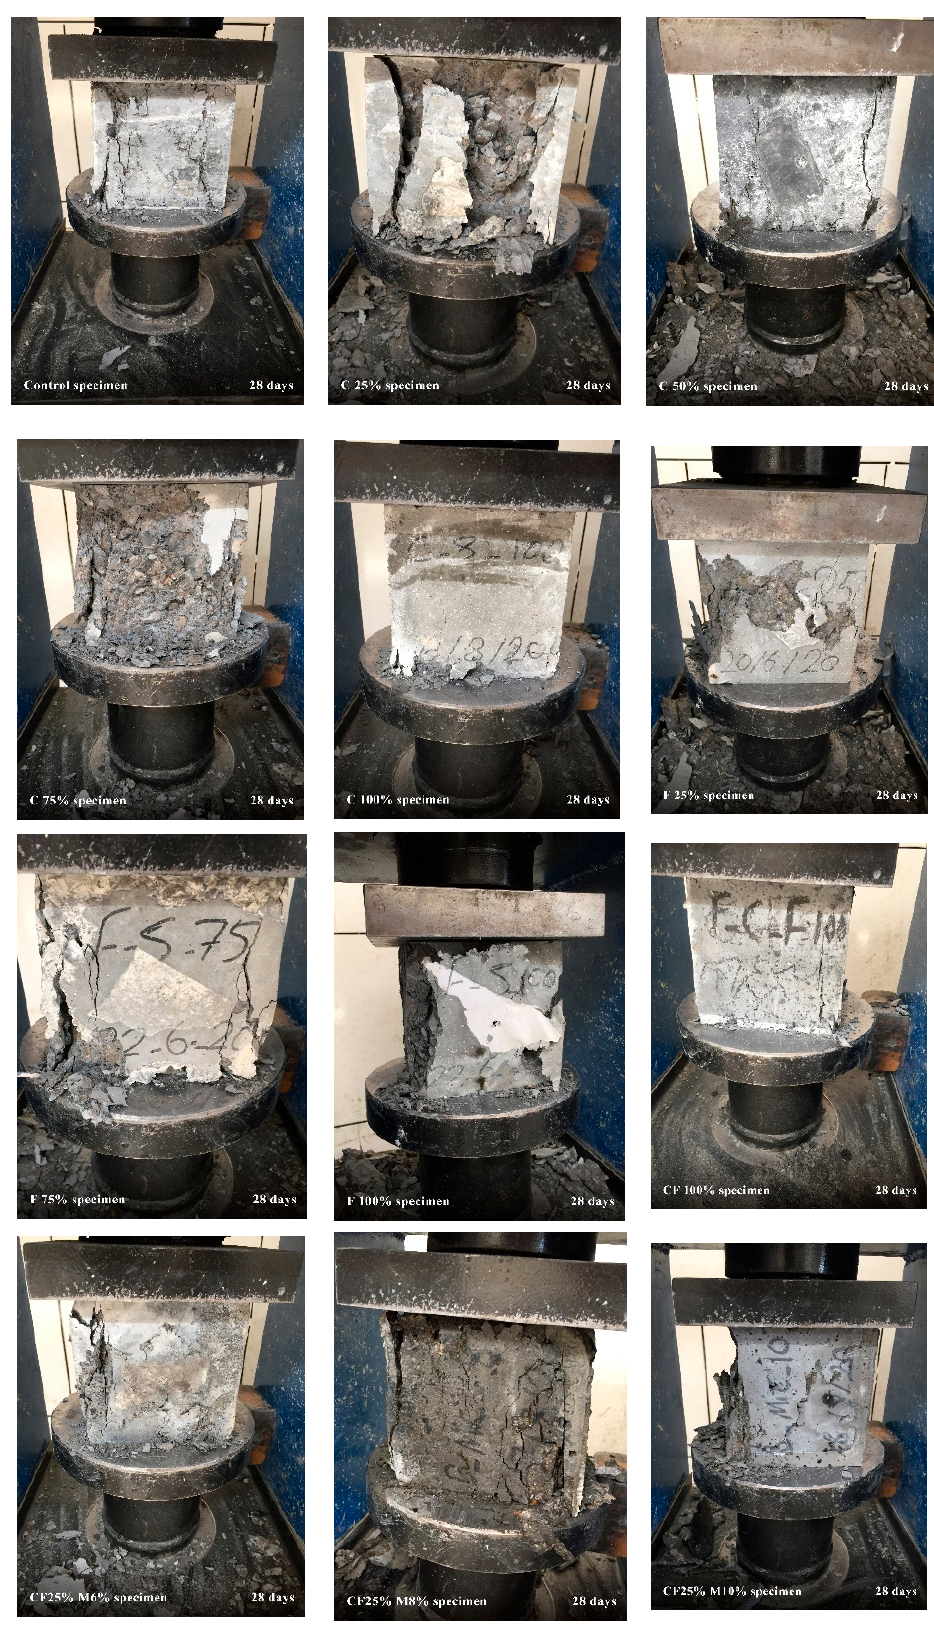
Figure 7. Crack patterns of the different mixes after the compressive strength test. Figure 8. Crack patterns of the different mixes after the compressive strength